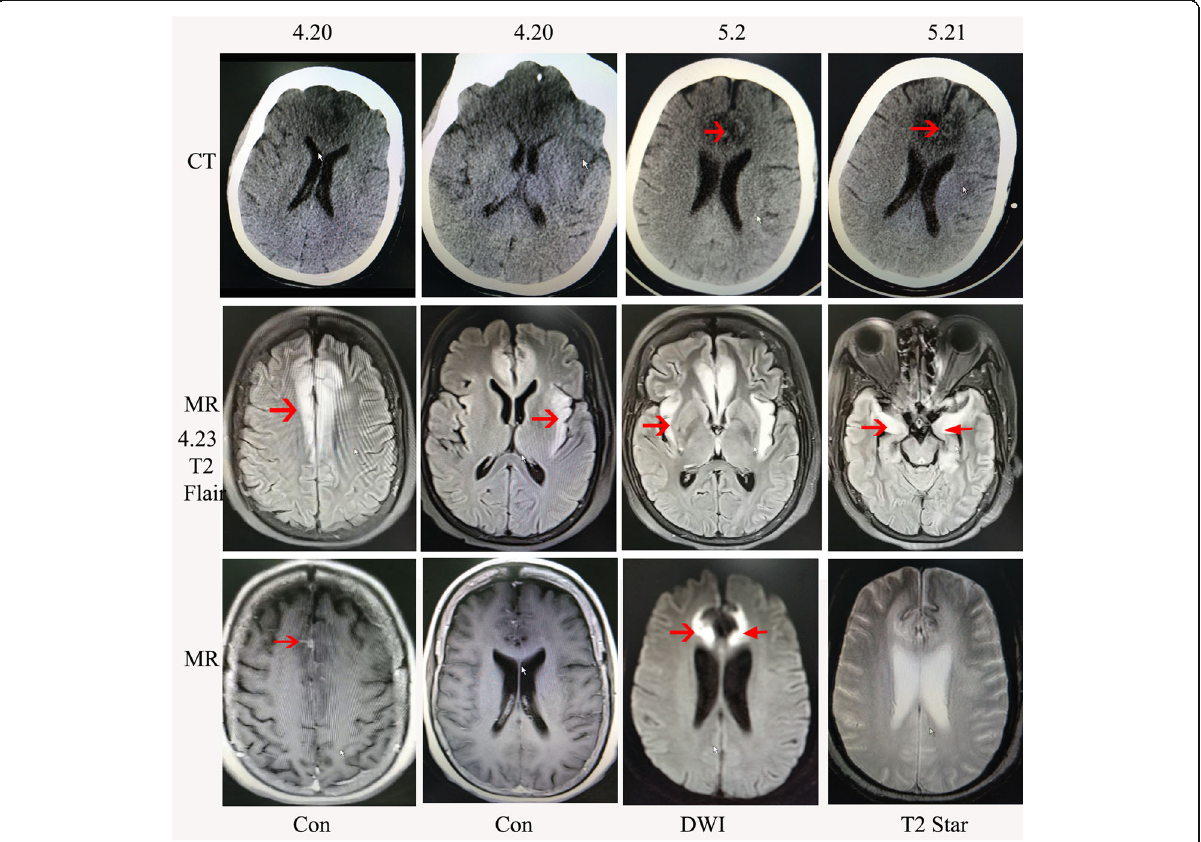
Fig. 2 CT and MRI images of the patient. Top: CT performed 3 days after admission (April 20th) showed low-density lesions at the bilateral frontal lobe and left insula (white arrows). The lesions were enlarged and bleeding observed at 2 weeks after admission (May 2nd) (red arrow). And the lesions did no significant change at about 5 weeks after admission (May 21st). Middle: The MRI T2 Flair showed hyper-intensity in the bilateral frontal lobes, insula, hippocampus and amygdala (April 23rd). Bottom: DWI also showed hyper-intensity in the above lesions (red